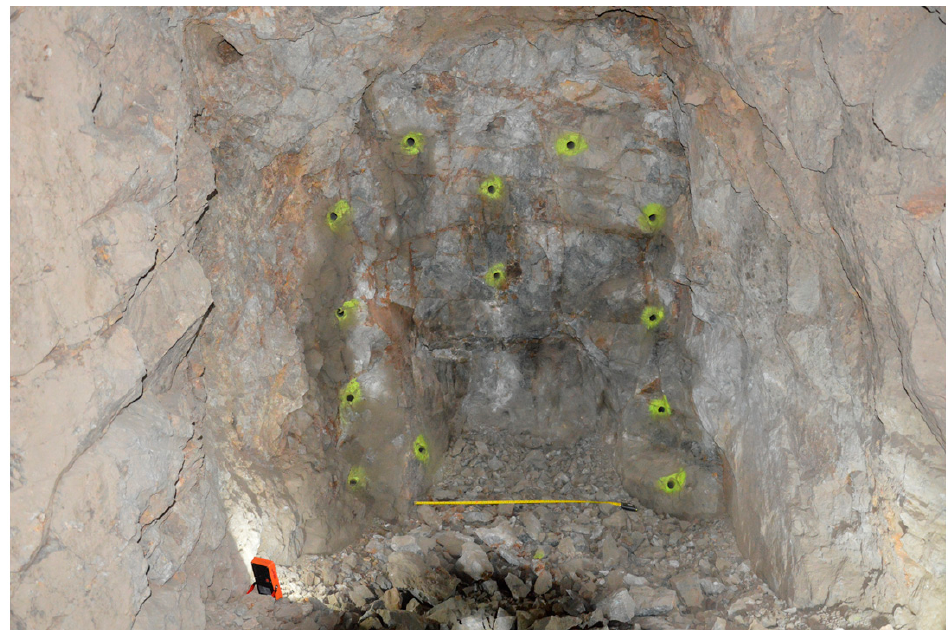
Figure A9. Cavity after detonation of hole with sequence number 8.